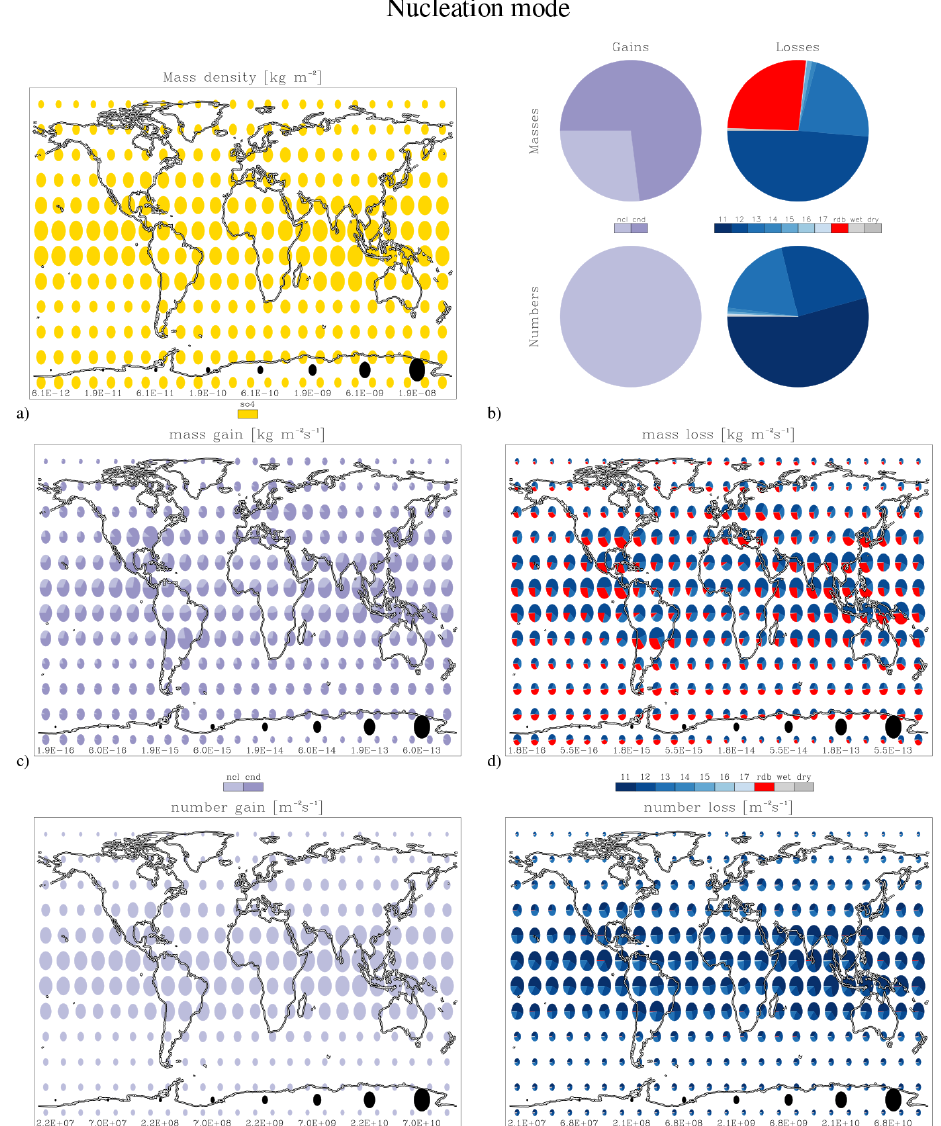
Figure 5. Global distribution of annual burdens (a) and tendencies (b, c, d, e and f) of the nucleation mode. The colors indicate either species (defined in Table 3) or processes (defined in Table 2). The pie chart shows fractional contributions, while the radius of the pie indicates total column burden or total column tendency (logarithmic scale as shown in black at the bottom of panels a, c, d, e and f ). Panel b shows a global average of the